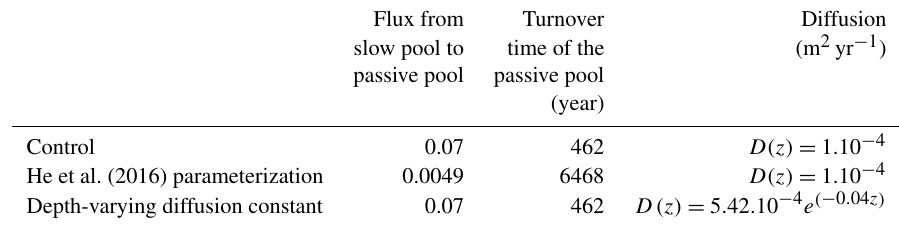
Table 2. The main differences between the three